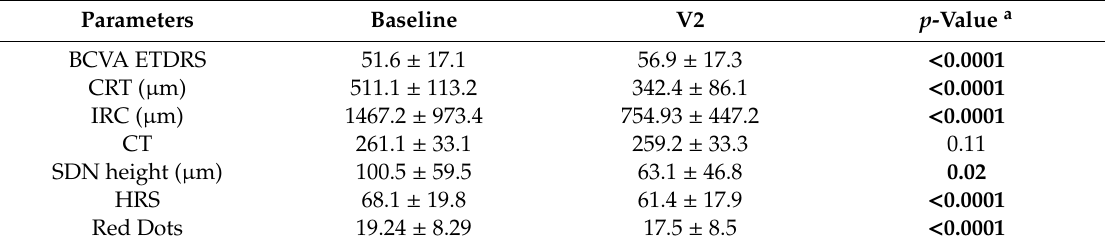
Table 2. Comparison between baseline and post-treatment (V2) data in the Ranibizumab group. Parameters